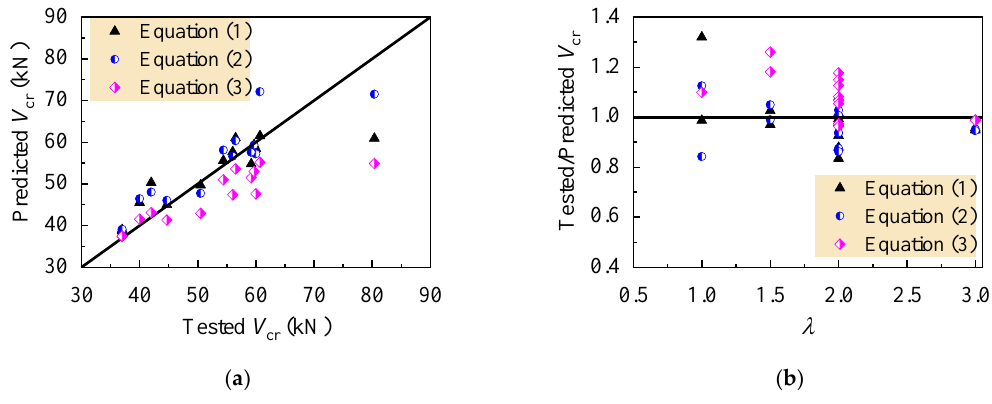
Figure 8. Comparison of tested with predicted shear-cracking force: ( a ) values; ( b ) ratios.